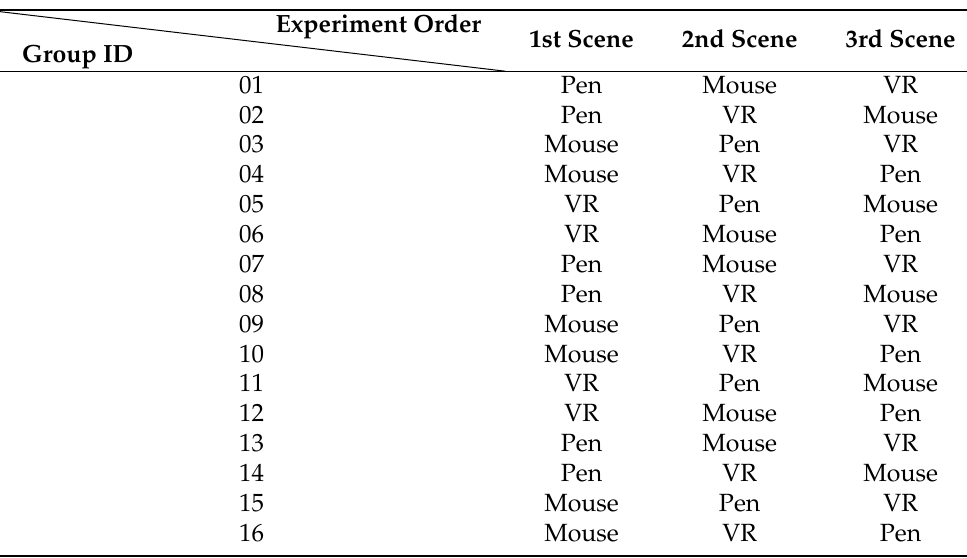
Table 3. The arrangement of the whiteboard efficiency evaluation experiment, regarding the order of the experiments for the three scenes: traditional whiteboard (pen), electronic whiteboard (mouse), and the proposed VR